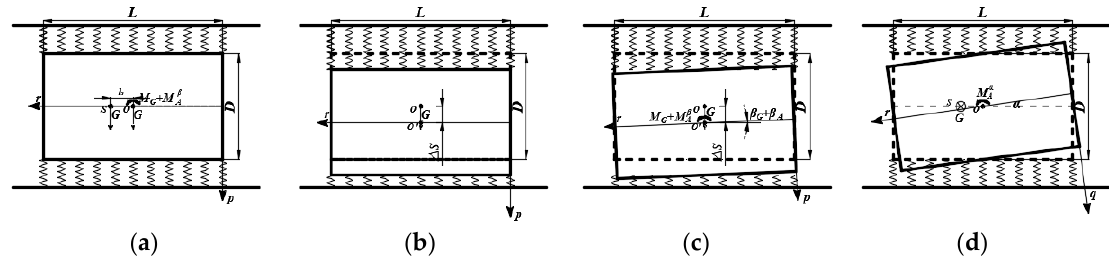
Figure 6. Shield–soil interaction model.